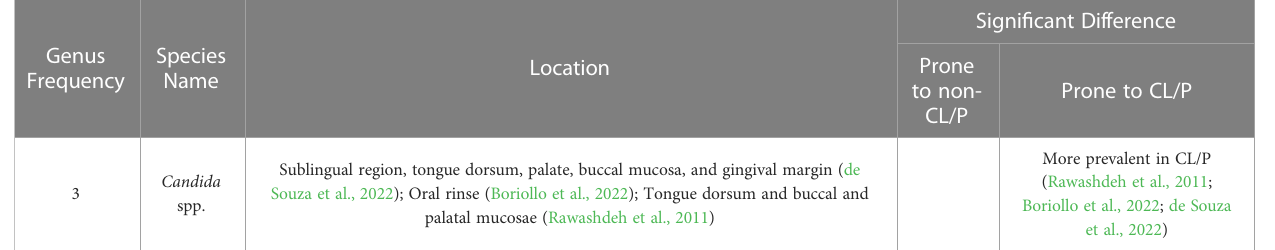
TABLE 5 Signi fi cant differences in Candida spp. and Candida species in CL/P and non-CL/P patients.